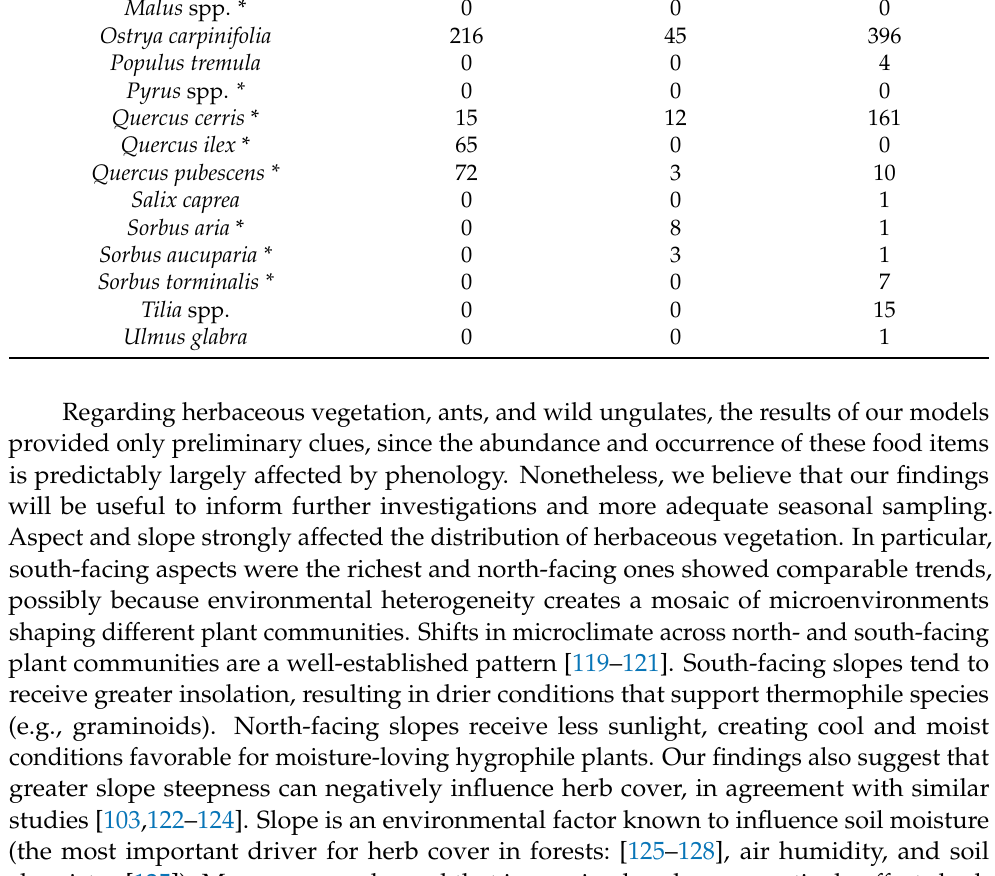
Table 6. Number of plants per hectare of tree species in the three sampled areas. Note the low frequency (except for beech) of key food species for Apennine brown bears (species marked with “*”) [26]. BAL LUC RdM Acer campestre 4 4 3 Acer opalus 52 5 91 Acer pseudoplatanus 12 1 0 Carpinus betulus 0 0 46 Carpinus orientalis 358 0 0 0 1 0 0 1 824 1056 Fraxinus ornus 146 52 191 Ilex aquifolium 0 0 1 4 0 0 1